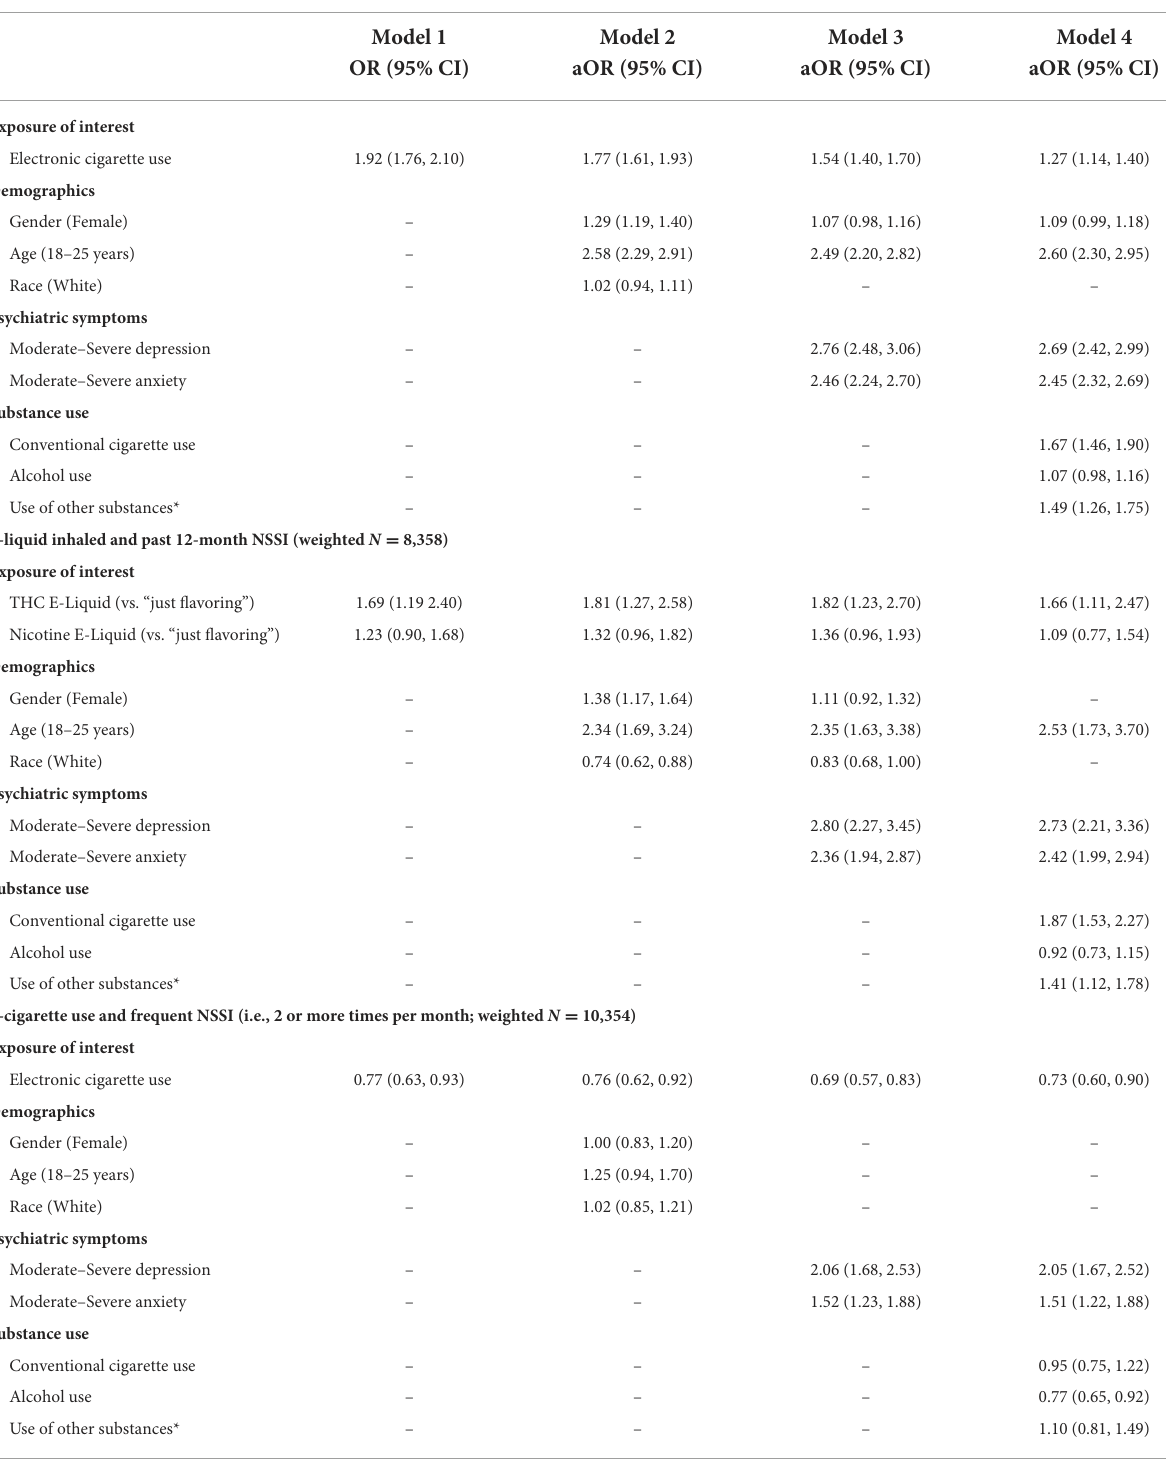
TABLE 5 Hierarchical logistic regression